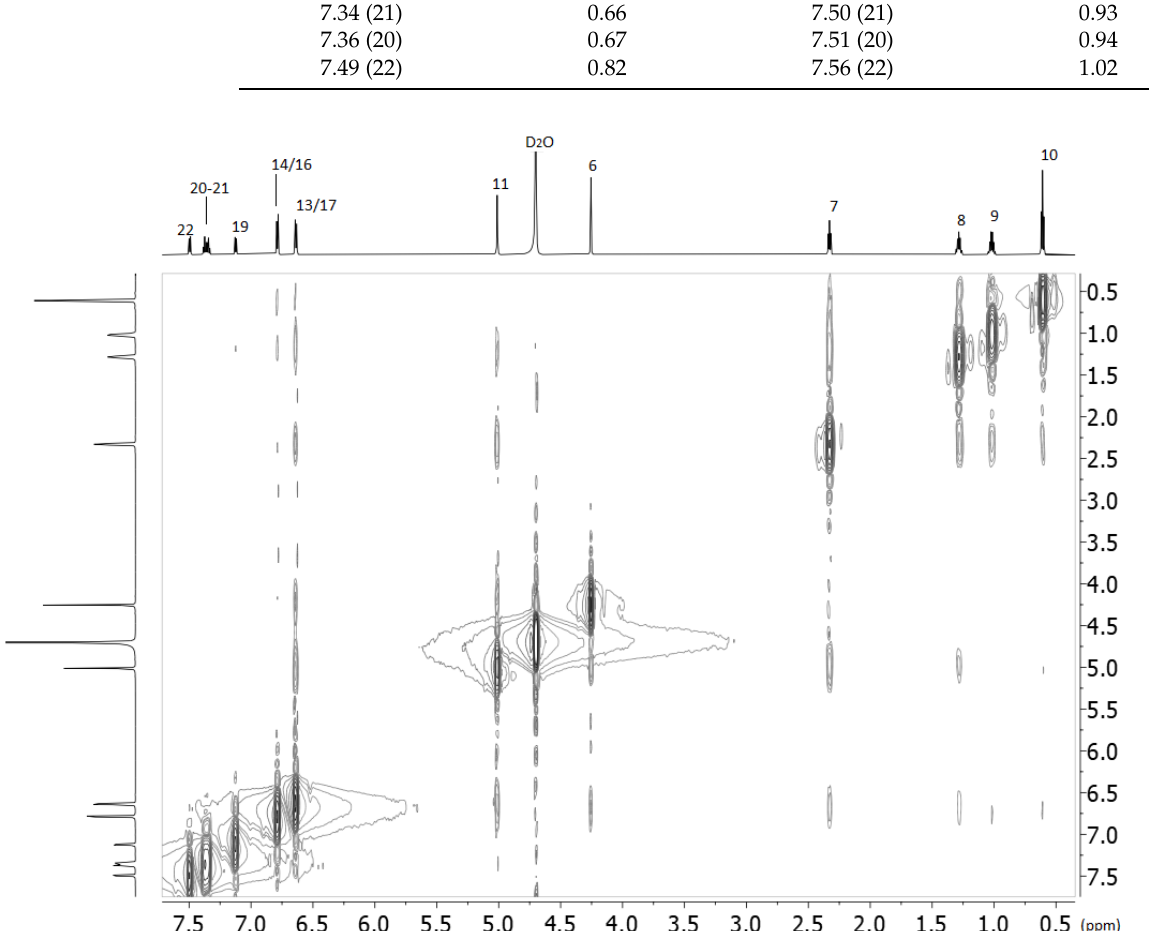
Figure 5. 2D ROESY spectra obtained with 700 MHz Bruker spectrometer using D 2 O solvent and at 25 °C of losartan.